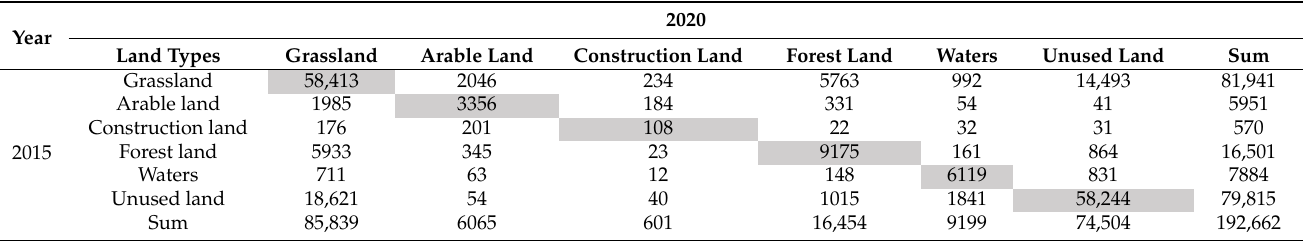
Table 7. Land use transfer matrix in the Qilian Mountains from 2015 to 2020 (km 2